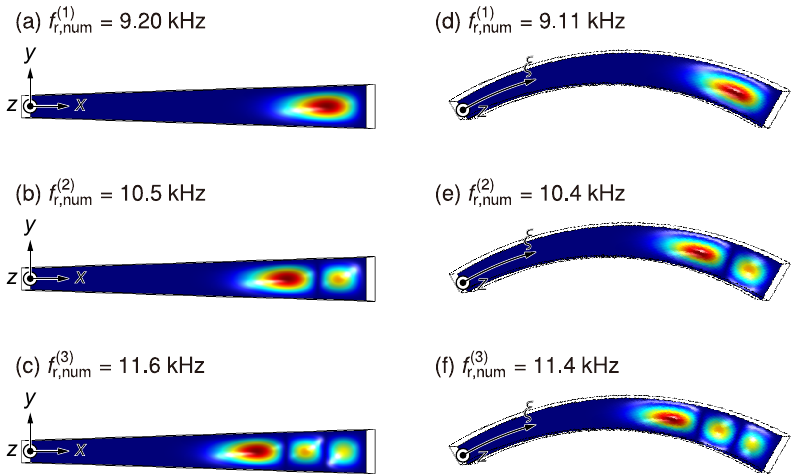
Figure 4. Numerical results of amplitude distribution in the xy plane for ( a – c ) the trapezoidal and ( i ) ( d – f ) curved membrane device for various f r,num , where i denotes the oscillation mode. Contours show the relative amplitude of each natural frequency, normalized by the maximum value of the oscillation amplitude. The amplitude distribution is symmetrical about the x - or ξ -axis, and the fundamental oscillation mode is in the direction of the y - or η -axis. Resonance positions indicated by the maximum amplitude are obtained for both the devices. Each device has the different resonance positions depending on the normal modes, and it is determined that both the devices have frequency selectivity. When the trapezoidal and curved devices are compared, it is confirmed that there is a negligible difference in their natural frequencies or